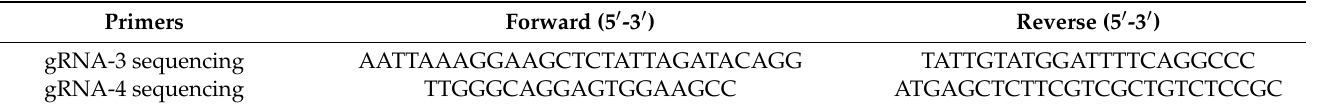
Table 2. The primers used for target site